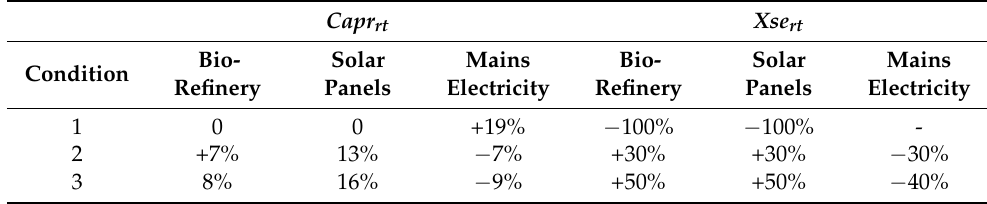
Table 7. Energy sources capacity variation effect.